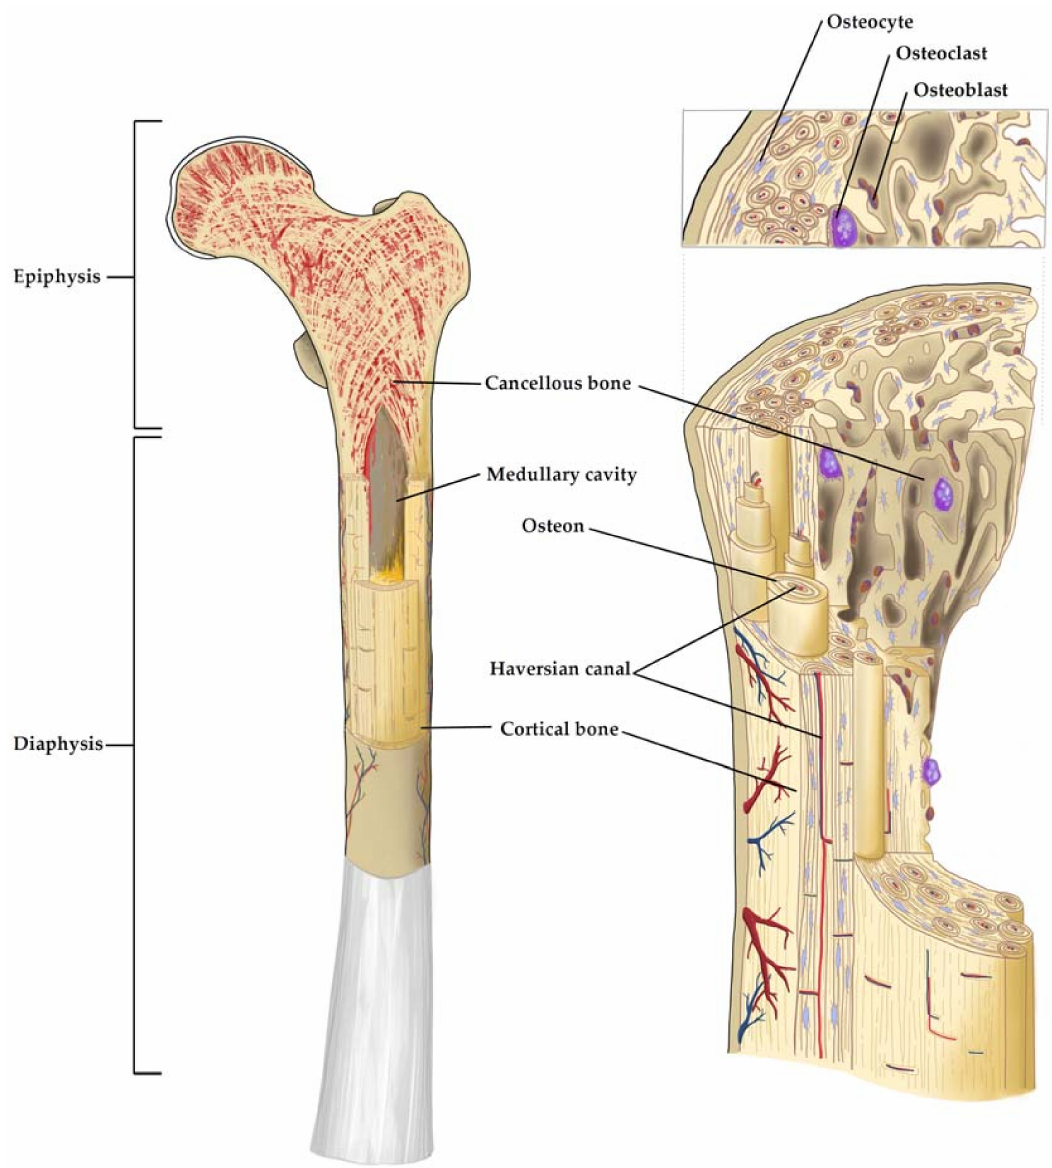
Figure 1. Bone Anatomy. A schematic drawing of the most profound anatomical features of bone, providing a cross section through cortical and cancellous bone while indicating the sites where the respective cells can be